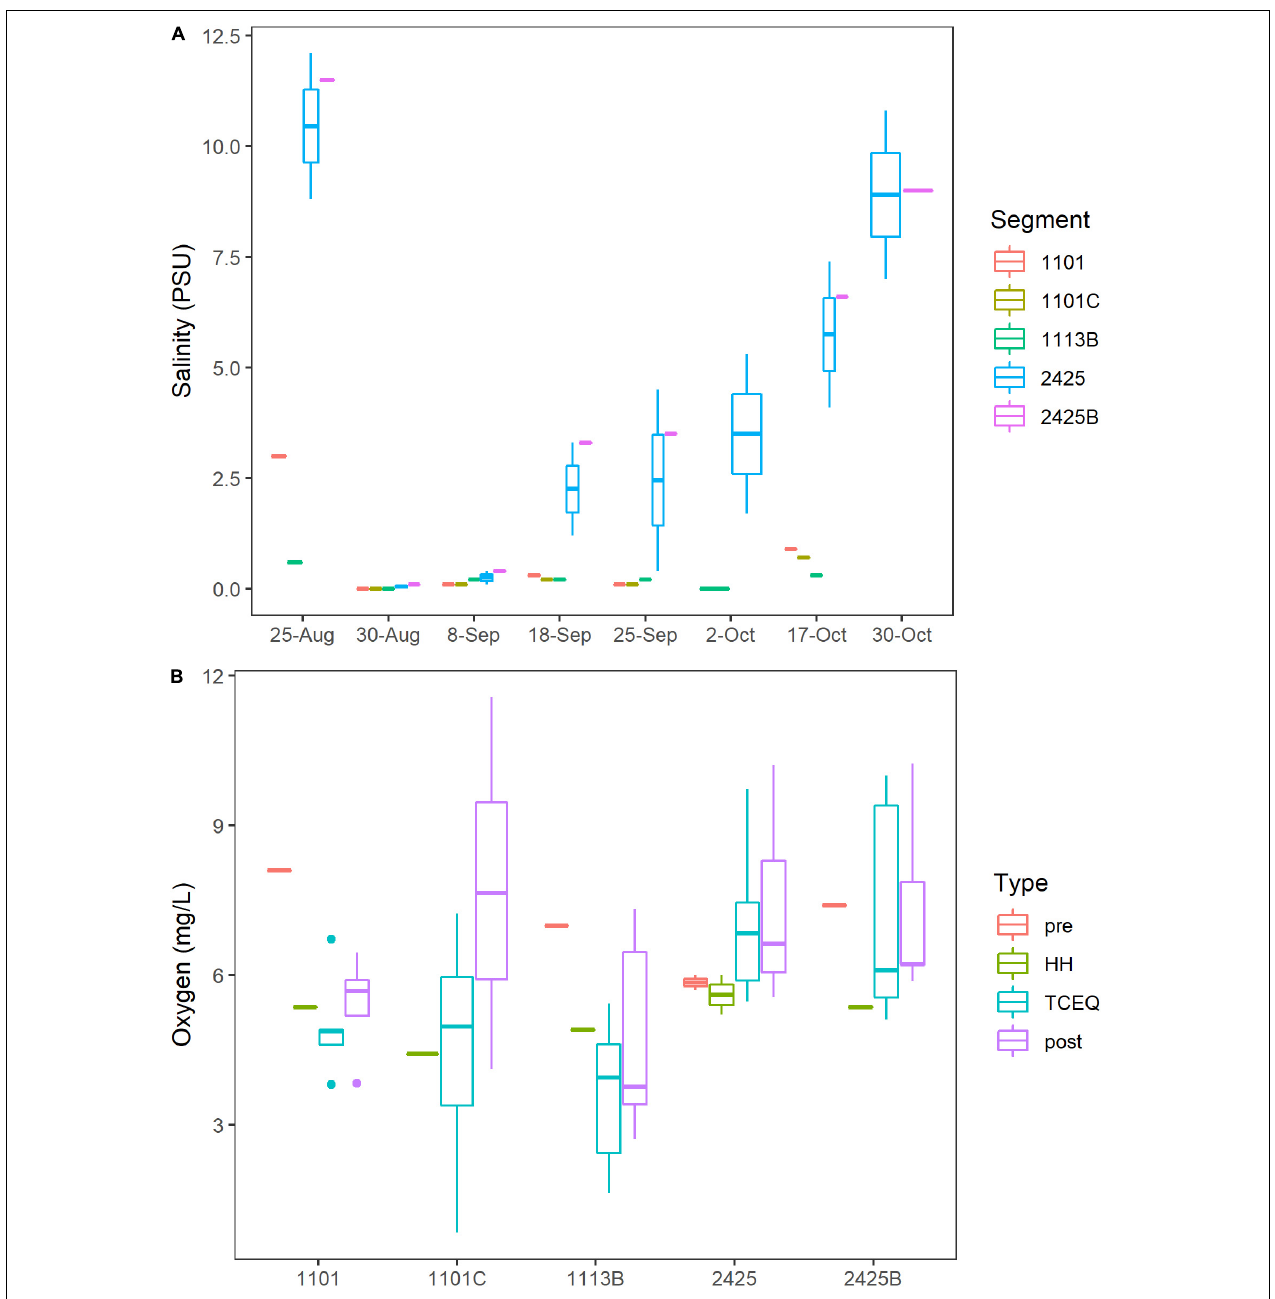
FIGURE 2 | Salinity and Oxygen. Water body segments are as Figure 1 . Boxes indicate 25 and 75% quantiles. Whiskers indicate range. Horizontal lines indicate median or, for segments where only one sample was taken, the value for that individual sample. Figure was generated with scripts in Supplementary File 3 . (A) Salinity concentrations in practical salinity units (PSU). All dates are 2017. (B) Boxplots of oxygen levels in the Clear Lake system. Sample type “pre” indicates samples collected on August 25th (before HH). Type “HH” indicates samples collected on August 30th (immediately after HH). Type “post” indicates samples collected from September 8th to October 30th. Type “TCEQ” indicates historical data collected by TCEQ and partner agencies during